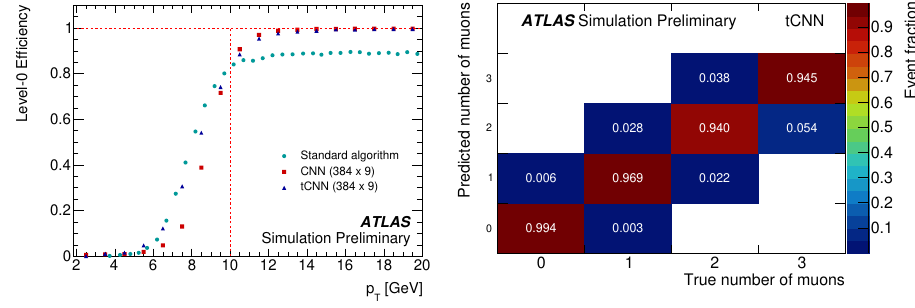
Figure 5. (Left) Trigger e ffi ciency of di ff erent algorithms as a function of the reconstructed p T . All the curves are realised taking single-muon images without a background as input and are tuned so that the e ffi ciency reached at nominal threshold (10 GeV) is the same (82%) to ease the comparison. (Right) Confusion matrix of the predicted number of muons vs the true number of muons (i.e. o ffl ine reconstructed number of muons)